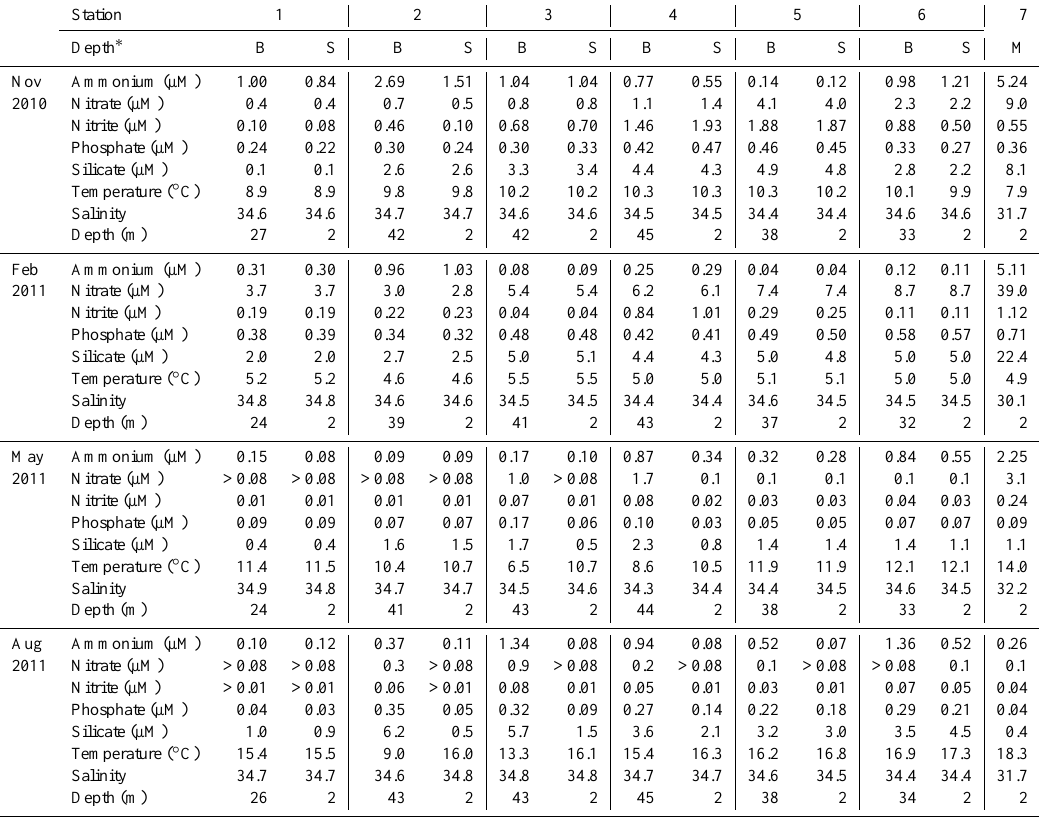
Table 1. Chemical, biological, and physical properties of surface (S) and bottom (B) water of the southern North Sea. Station